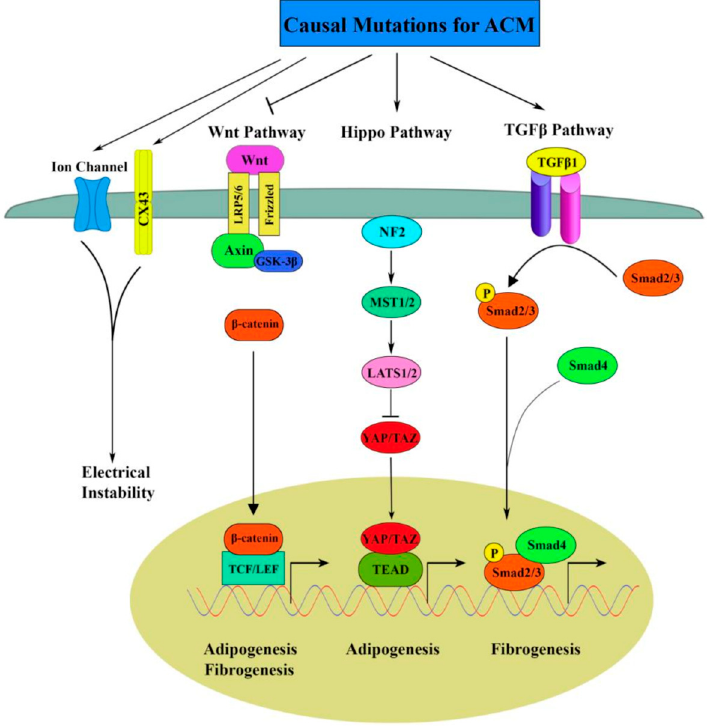
Figure 10. Molecular pathogenic signaling pathways in ACM. Reproduced with permission from Gao et al., International Journal of Molecular Sciences; Published by MDPI open access 2020 [88].